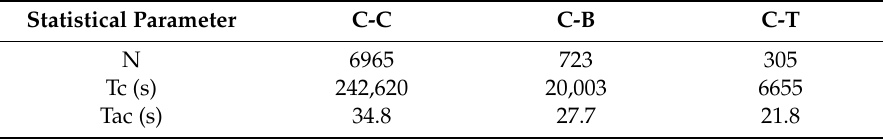
Table 1. Car-following dataset